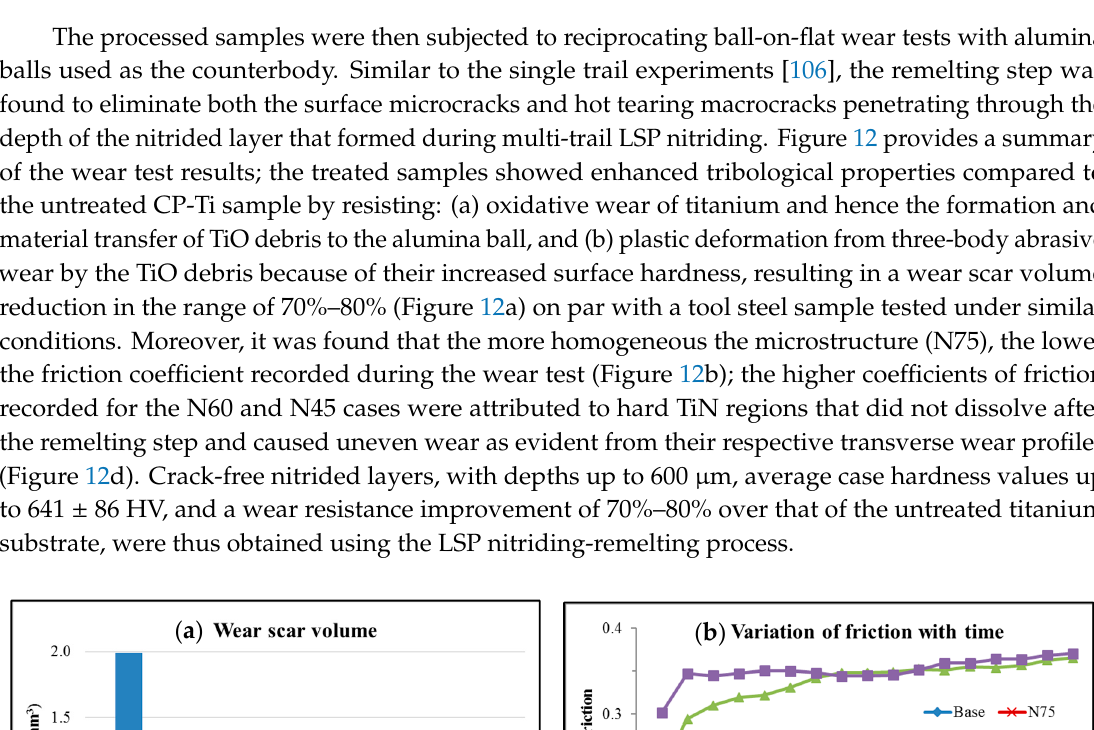
Figure 11. Optical micrographs of transverse cross-section: ( a ) N45 (870 HV, surface cracks), ( b ) N60 (621 HV, no surface cracks), and ( c ) N75 (547 HV, no surface cracks). Reprinted with permission from Ref. [112]. Copyright 2017 Elsevier.